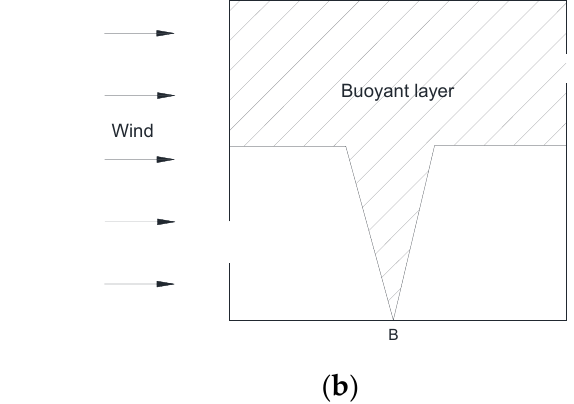
Figure 11. Displacement flow in naturally ventilated enclosure. Adapted from Hunt and Linden [44] and Hunt and Linden [47], with the absence ( a ) and presence ( b ) of a continuous buoyant source.